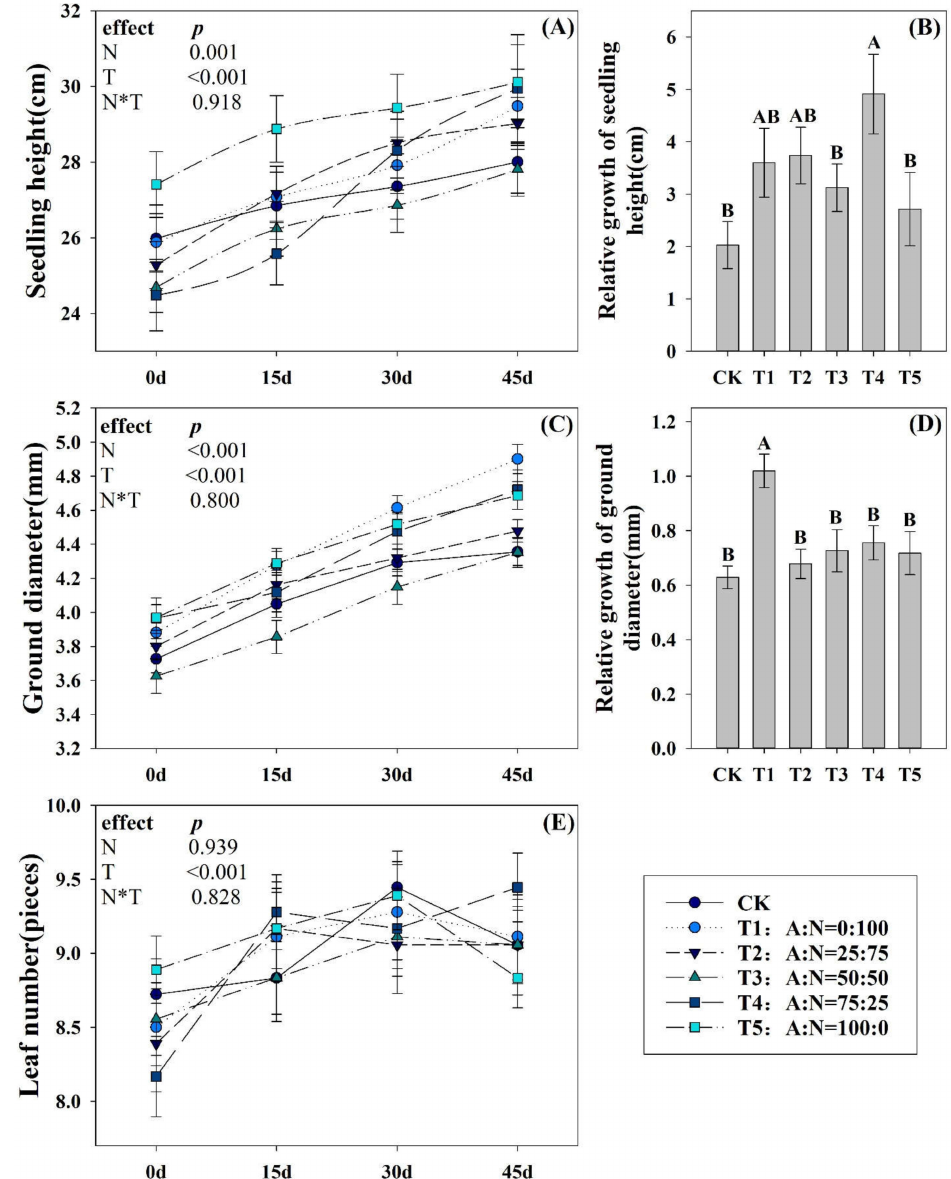
Figure 1. Differences of seedling height, ground diameter, and leaf number of pecan seedlings under varying NH 4 + :NO 3 − ratios. Changes in seedling height of pecan seedlings over time un- der varying NH 4+ :NO 3 − ratios ( A ). Relative growth of seedling height of pecan seedlings under varying NH 4+ :NO 3 − ratios ( B ). Changes in ground diameter of pecan seedlings over time under varying NH 4+ :NO 3 − ratios ( C ). Relative growth of ground diameter of pecan seedlings under vary- ing NH 4+ :NO 3 − ratios ( D ). Changes in leaf number of pecan seedlings over time under varying NH 4+ :NO 3 − ratios ( E ). Uppercase letters indicate differences between NH 4+ :NO 3 − ratio treatments, at p <